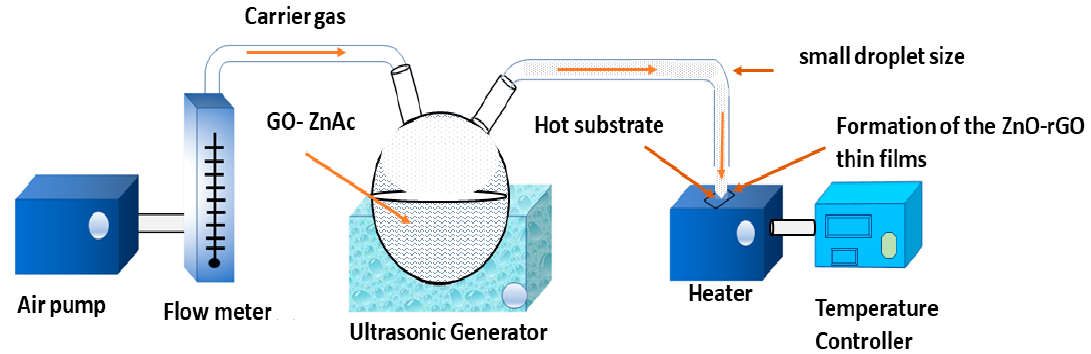
Scheme 2. Illustration of the diagram of ultrasonic spray pyrolysis (USP) system. Scheme 2 . Illustration of the diagram of ultrasonic spray pyrolysis (USP) system.